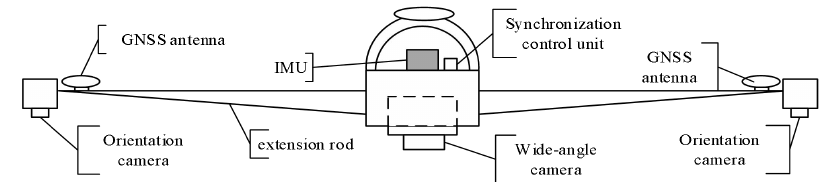
Figure 1. Schematic figure of the mapping system and its main components